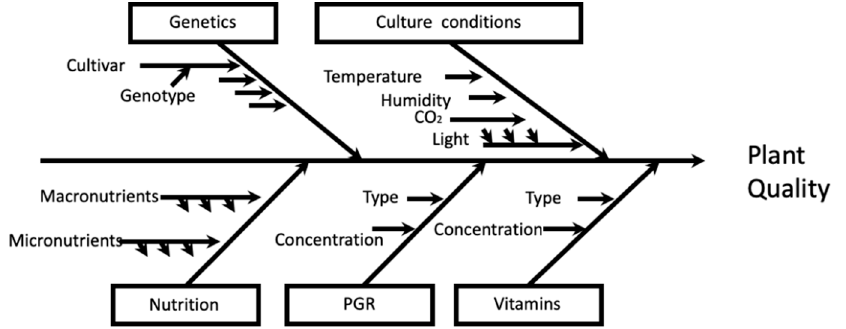
Figure 2. Ishikawa diagram representing the main group factors related with the plant material, in vitro culture conditions, and media composition (minerals, plant growth regulator and vitamins) affecting micropropagated plant quality.